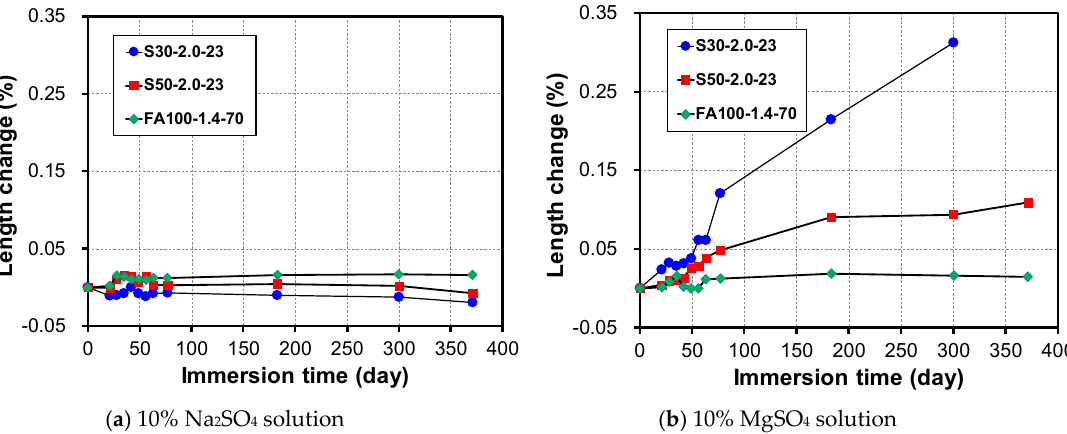
Figure 6. Change in length depending on binder types, immersed in ( a ) 10% Na 2 SO 4 solution and ( b ) 10% MgSO 4 solution.